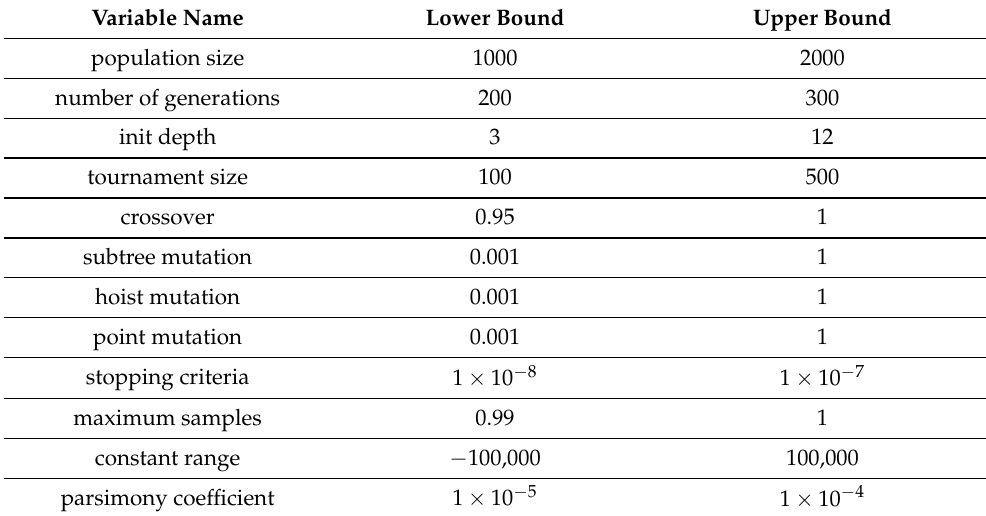
Table 3. The range of hyperparameters used in random hyperparameter